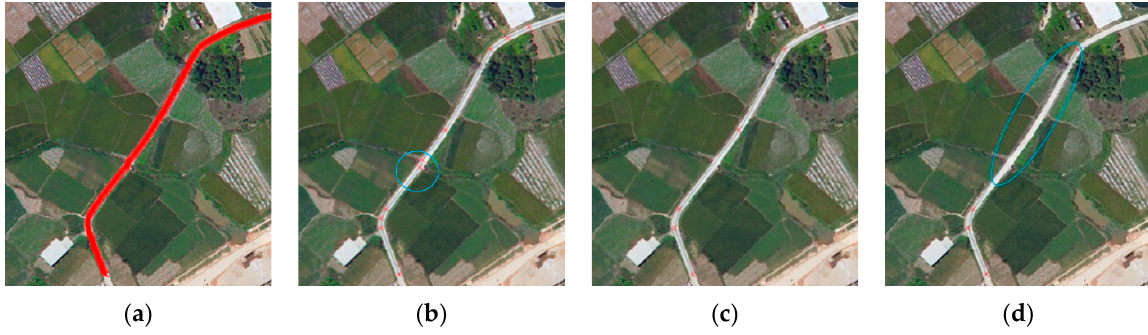
Figure 15. Results of different simplifying thresholds: ( a ) tracking result; ( b ) result when k = 1; ( c ) result when k = 3; ( d ) result when k = 5.